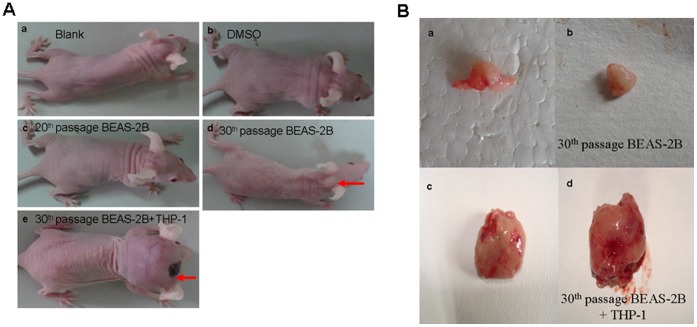
Larger tumor was formed in nude mice transplanted with mixed CTPE-induced BEAS-2B cells at passage 30 and THP-1 cells.(A) Representative examples of tumor formation in nude mice on the 30th day after injection (n = 6/group). (a) untrested BEAS-2B cells, (b) BEAS-2B cells induced with DMSO, (c, d) CTPE-induced BEAS-2B cells at passage 20 and 30, (e) CTPE-induced BEAS-2B cells at passage 30 mixed with THP-1 cells. Red arrow showed tumors. (B) Representatives of tumor removed from nude mice after 30 days transplantion. (a–b) CTPE-induced BEAS-2B cells at passage 30, (c-d) CTPE-induced BEAS-2B cells at passage 30 mixed with THP-1 cells.